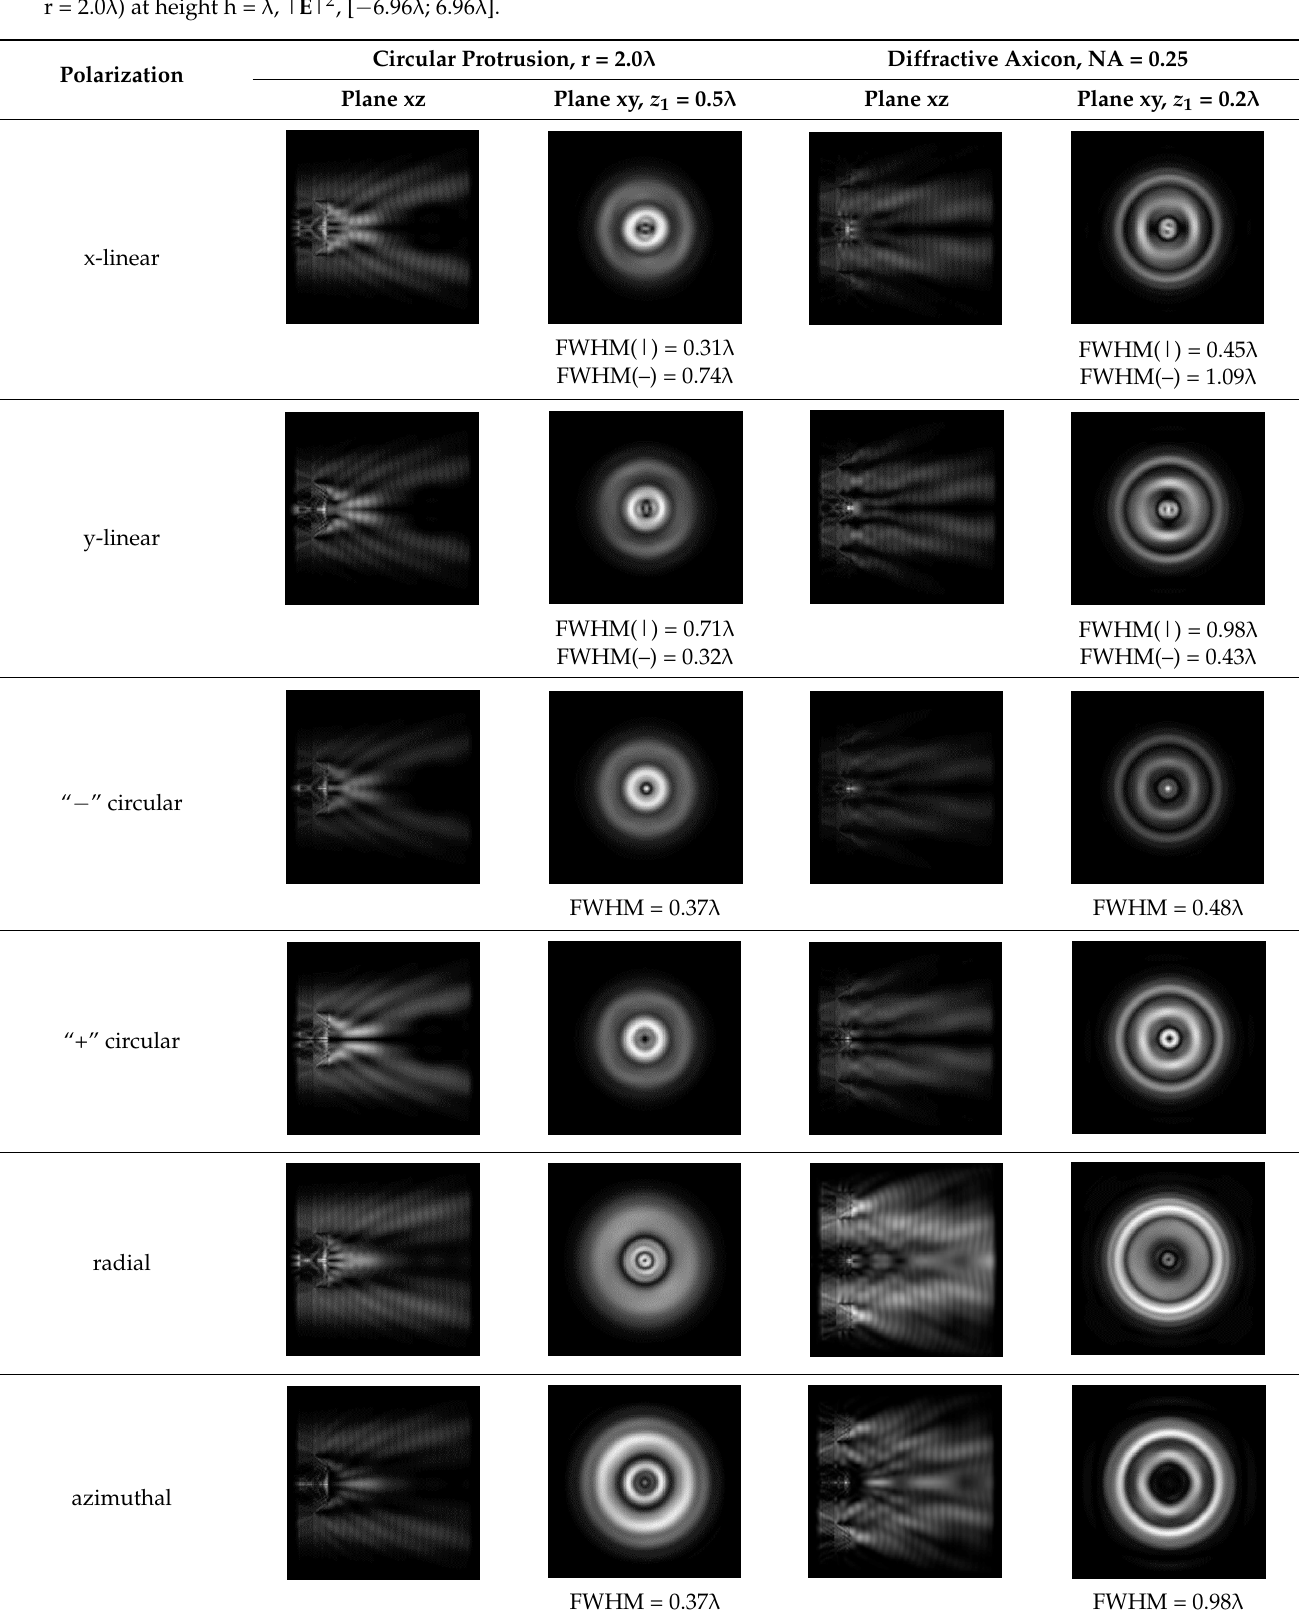
Table 5. The diffraction of Laguerre–Gauss mode (0,1) by a diffractive axicon (NA = 0.25) and silicon cylinder (protrusion, r = 2.0 λ ) at height h = λ , | E | 2 , [ − 6.96 λ ; 6.96 λ ].